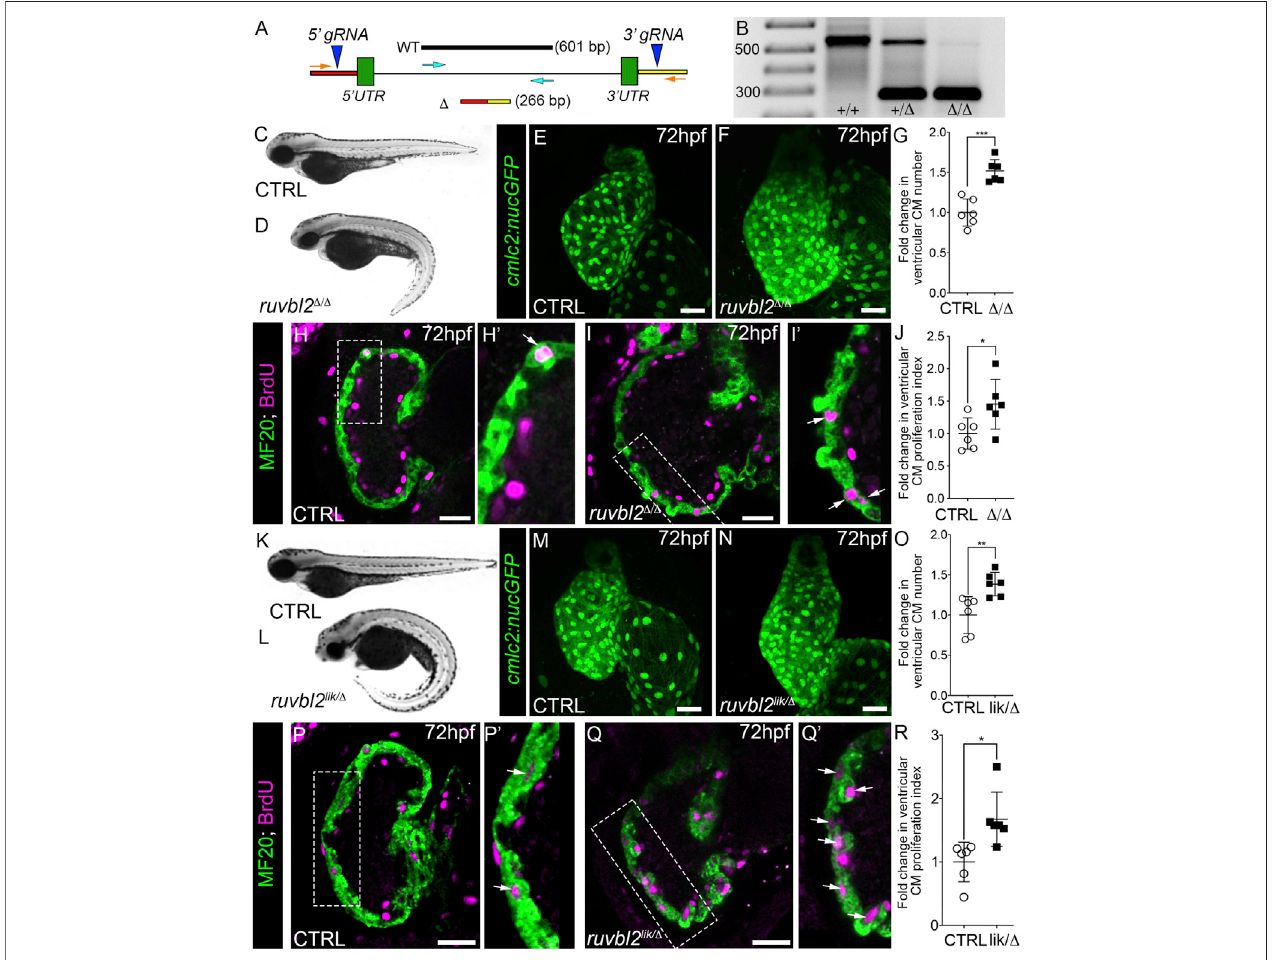
FIGURE 2 | Ruvbl2 suppresses cardiomyocyte proliferation during embryonic heart growth. (A) Schematic of the ruvbl2 locus deletion ( ruvbl2 Δ ) targeting strategy by CRISPR-Cas9 genome editing. gRNAs (blue arrowheads) were designed that target genomic regions outside of the ruvbl2 5 ′ and 3 ′ UTR. Location of PCR primers used to detect the wild-type (WT; turquoise arrows) and mutant ( Δ ; orange arrows) alleles. (B) Image of a DNA agarose gel showing amplicons for the wild-type (+) and mutant ( Δ ) alleles. (C,D) and (K,L) Bright fi eld images of wild-type (C,K) , ruvbl2 Δ / Δ (D) , ruvbl2 lik/ Δ (L) embryos at 72 hpf. Anterior left, lateral view. (E,F) and (M,N) Confocalprojectionsof fl uorescentcardiomyocytenucleiinheartsof72 hpfCTRL(F; n =6andM; n =6), ruvbl2 Δ / Δ (G; n =6),and ruvbl2 lik/ Δ (N; n =6) Tg ( cmlc2:nucGFP ) embryos. (G,O) Quanti fi cation of fold change in ventricular cardiomyocyte number in 72 hpf CTRL and ruvbl2 Δ / Δ (G) or CTRL and ruvbl2 lik/ Δ (O) hearts. Means ± s.d are shown. *** p < 0.001; ** p < 0.01. (H – I ’ ,P – Q 9 ) Single plane confocal images of CTRL (H; n = 6 and P; n = 6), ruvbl2 Δ / Δ (N; n = 6), and ruvbl2 lik/ Δ (Q; n = 6) hearts double immunostained to detect cycling (BrdU+) cardiomyocytes (MF20+) at 72 hpf. Boxed regions in (H,I,P,Q) are magni fi ed in (H 9 ,I 9 ,P 9 ,Q 9 ) with white arrows highlighting double positive cells. (J,R) Quanti fi cation of cardiomyocyte proliferation indices in CTRL and ruvbl2 Δ / Δ (J) or CTRL and ruvbl2 lik/ Δ (R) ventricles. Means ± s.d are shown. * p < 0.05. Scale bars: 25 μ